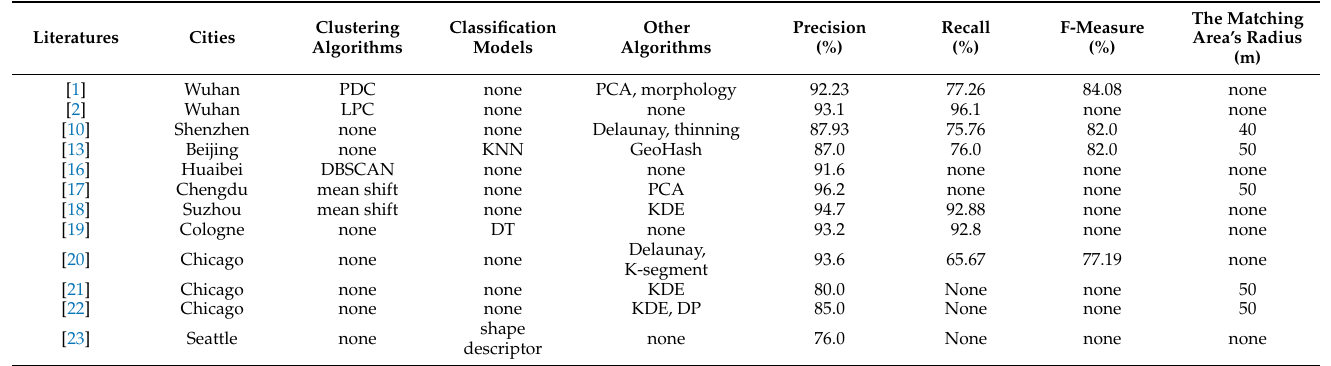
Table 1. Comparisons of algorithms and the performance among the related